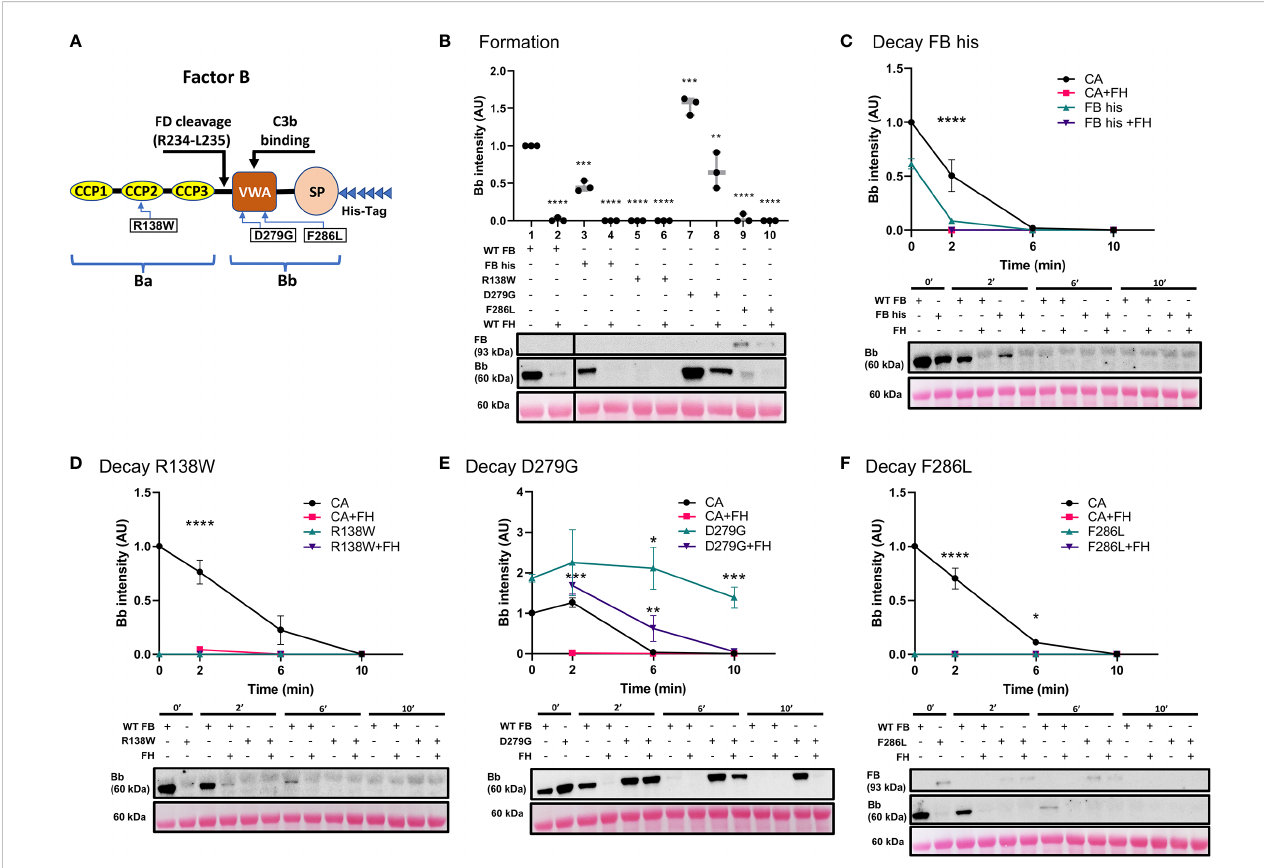
FIGURE 5 Variants in CFB can affect its af fi nity for C3b binding and rate of C3 convertase decay in presence/absence of FH. (A) Schematic of recombinant FB proteins, blue arrows denoting the positions of speci fi c mutants. (B) Western blot analysis of C3 convertase formation. Recombinant WT FB (FB his) shows decreased ability to form C3 convertase (lanes 3) as compared to WT FB (CA, lanes 1). There is no formation in presence of FH (lanes 2 and 4). Both p.Arg138Trp (lanes 5-6) and p.Phe286Leu (lanes 9-10) fail to form C3bBb in absence/presence of FH. p.Asp279Gly increases C3 convertase formation ~1.5-fold (lane 7) as compared to CA (lane 1) and is able to form C3bBb even in presence of FH (lane 8). Results were normalized to CA and presented as relative protein expression. Box plots show median, 1 st and 3 rd quartile ranges, and the individual data points of three independent experiments. Signi fi cance calculated for WT FB. (C) Western blot analysis of CA formed using WT FB or FB his, then decayed in presence/absence of FH. Decrease in C3 convertase at 0 and 2 min is observed as compared to WT FB. (D) Western blot analysis of CA formed using WT or p.Arg138Trp, then decayed in absence/presence of FH. No mutant convertase activity is observed at 0 min as compared to WT FB. (E) Western blot analysis of CA formed using WT or p.Asp279Gly, then decayed in absence/presence of FH. Decrease in natural and FH-mediated decay of p.Asp279Gly C3bBb is observed as compared to WT FB at all timepoints. (F) Western blot analysis of CA formed using WT or p.Phe286Leu, then decayed in absence/presence of FH. No mutant convertase activity is observed at 0 min as compared to WT FB. For all decay experiments, results were normalized to CA at 0 min and presented as relative protein expression. Ponceau S Staining was used as a measure of total protein load. Statistical signi fi cance shown for comparisons between CA/recombinant protein and CA+FH/recombinant protein+FH respectively at the same timepoint. Mean±SD of three independent experiments. * P